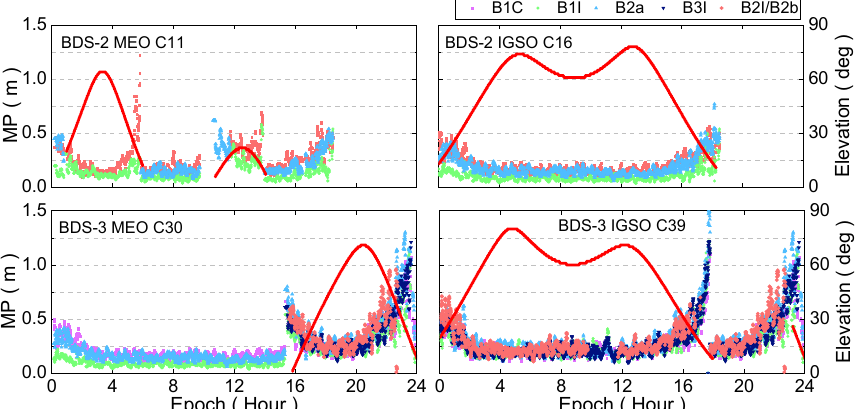
Figure 3. The MP series of BDS-2 and BDS-3 for DOY 283 on JFNG station. (The red wave indicates the sequence of elevation angle).